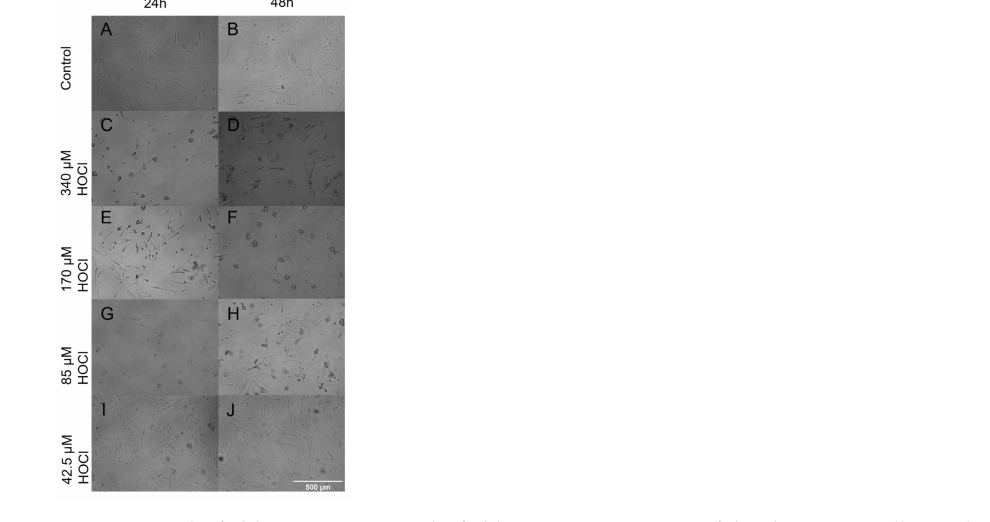
Figure 6. Bright-field microscopy. Bright-field microscopy images of the changes in cell morphology of primary human lung fibroblasts post-exposure to HOCl at 24 h and 48 h timepoints. ( A – J ) were viewed at 10 × magnification using the time-lapse microscope. Images are representative of n = 5.